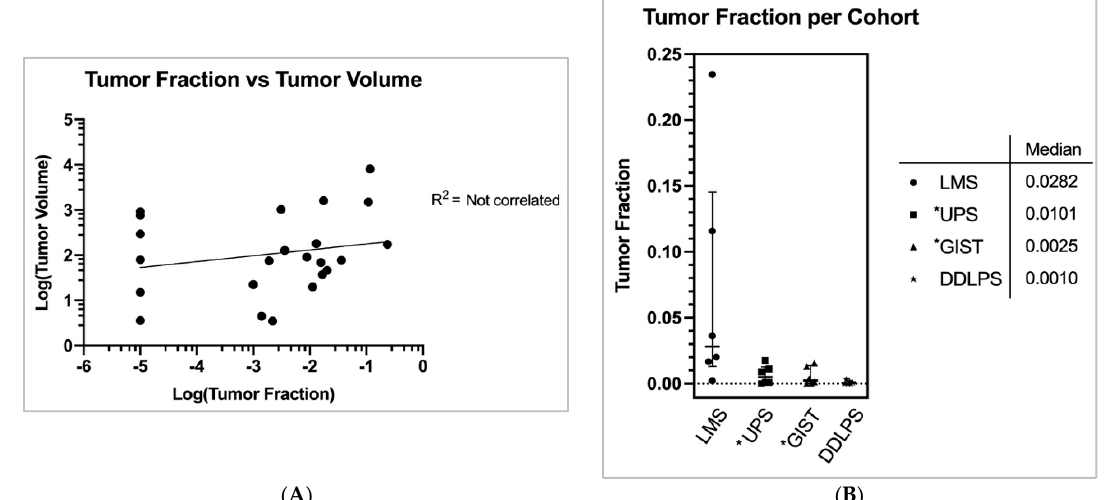
Figure 2. ( A ) Estimated tumor fraction, i.e., the fraction cell free DNA derived from tumor rather than non-cancerous tissue, was calculated per Foundation Medicine. Each subject was administered an estimated tumor fraction (TF) seen here in this figure. The median TF in each cohort roughly correlates with the observed concordances from Figure 3B. Figure graphically depicts median with interquartile range. * = TF reevaluated due to the presence of germline mutations. ( B ) Each subject’s volumetric sum of all cancerous lesions were added and plotted against Foundation Medicine’s computed estimated tumor fraction. A logarithmic scale was applied to both axes for better visual representation. Subjects with TF of zero were provided with an arbitrary TF of 0.00001 for the log-log plot. No correlation was observed. Moreover, no significant correlation was observed when comparing TF vs number of metastases nor tumor volume vs number of metastases (Figure S1A,B).